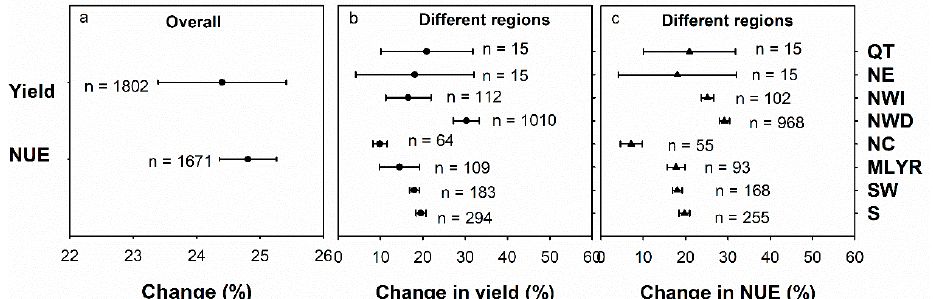
Figure 3. The response of change in potato yield and NUE to mulching compared to no mulching average for China ( a ), for the eight regions for potato yield ( b ), and for NUE ( c ). Abbreviations: NC, North–Central China; QT, Qinghai and Tibet; NE, Northeast China; NWI, Northwest irrigation region; NWD, Northwest dryland region; MLYR, the middle and lower reaches of the Yangtze River; SW, Southwest China; and S, South China). Error bars represent 95% confidence intervals. The values for n represent the corresponding number of